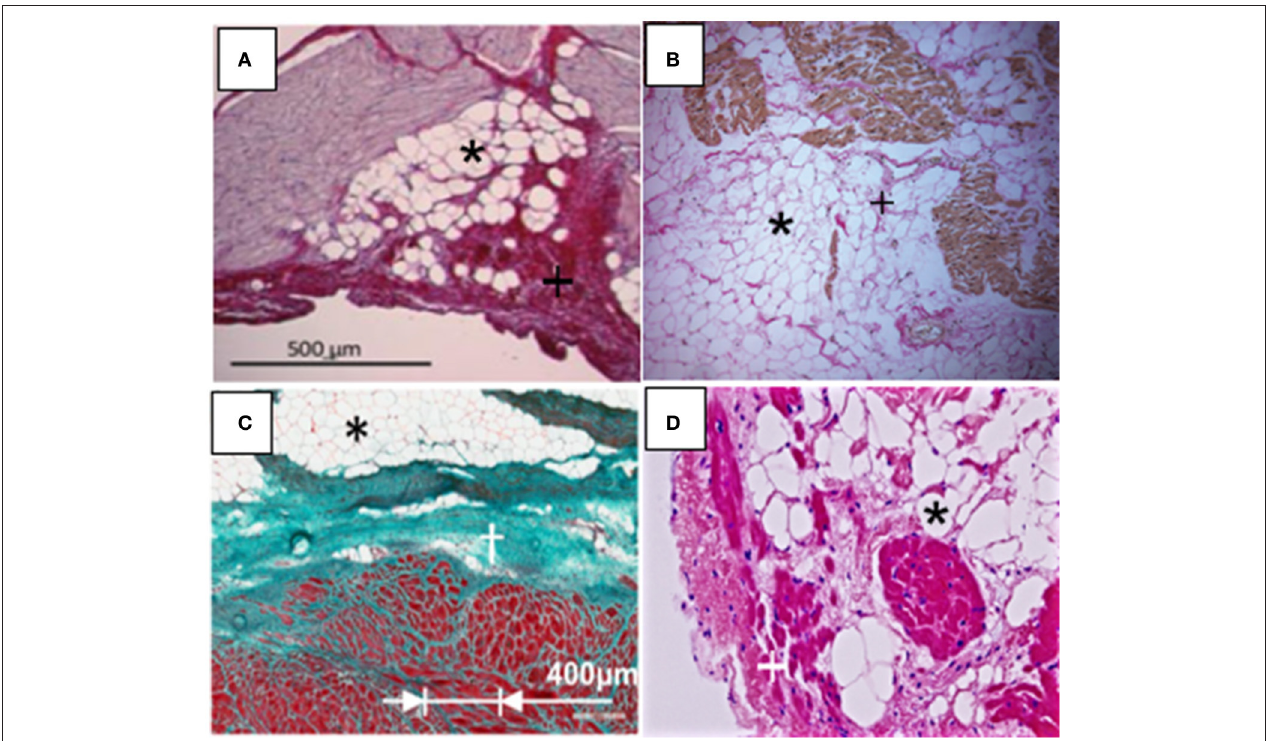
FIGURE 3 | Disease associated myocardial fibro-fatty infiltrations (Fatty infiltrations, black asterisks; fibrosis, black or white crosses). (A) Atrial fibrillation (modified from Haemers et al., 2015). (B) Myotonic Dystrophy (magnification, 100X) (modified from Christensen et al., 2008). (C) Myocardial infarction (modified from Pouliopoulos et al., 2013 ). (D) Arrhythmogenic right ventricular cardiomyopathy (magnification, 200X). (Modified from Deshpande et al.,